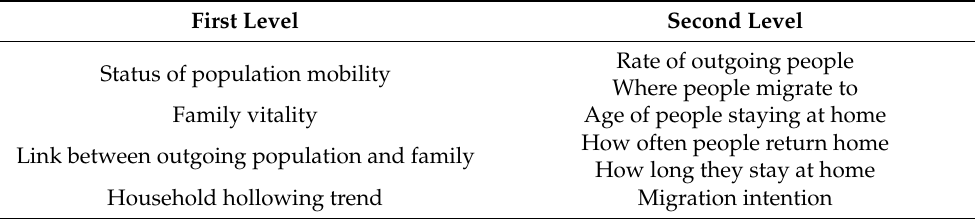
Table 2. Evaluation index system of household